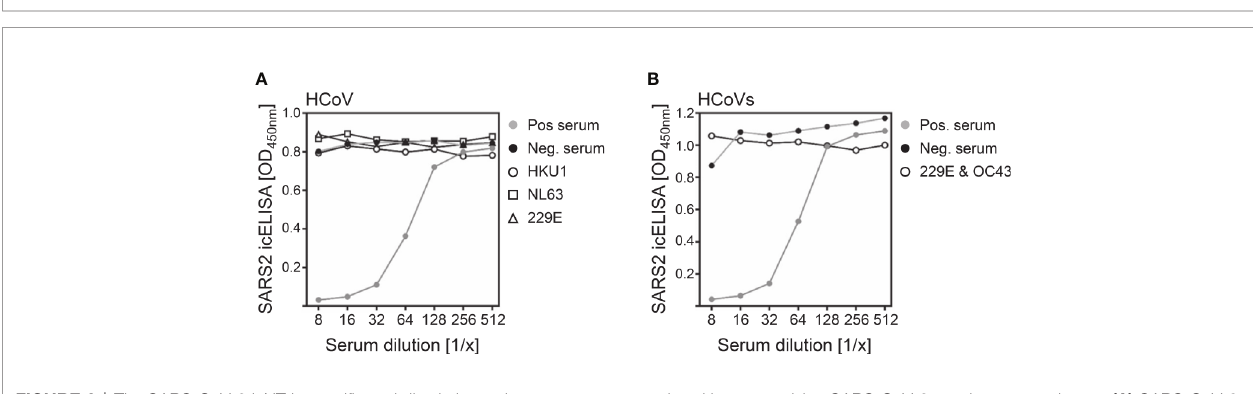
FIGURE 6 | The SARS-CoV-2 icNT is speci fi c and discriminates between serum samples either recognizing SARS-CoV-2 or other coronaviruses. (A) SARS-CoV-2 was incubated with indicated dilutions of serum samples for 1 h before Vero E6 cells were infected. Neutralizing capacity was evaluated by icELISA. Serum samples were obtained from individuals positively tested by diagnostic PCR (performed at the diagnostics department of the Institute for Virology of the University Hospital Essen) for HCoV-HKU1, HCoV-NL63, or HCoV-229E. Serum samples were taken at 2 to 3 months post symptom onset and positive PCR testing. (B) As in (A) , but a serum sample of an individual who experienced co-infection of two HCoVs was used. The individual was positively tested for HCoV-229E and